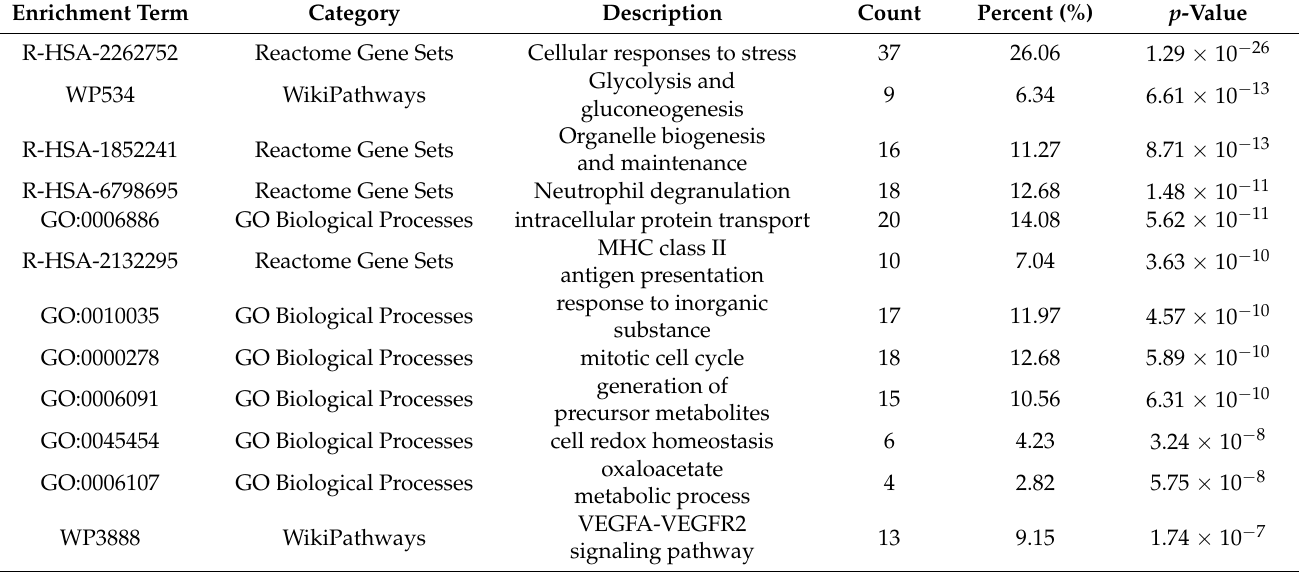
Table 1. Functional enrichment of TbrMam proteins by tool